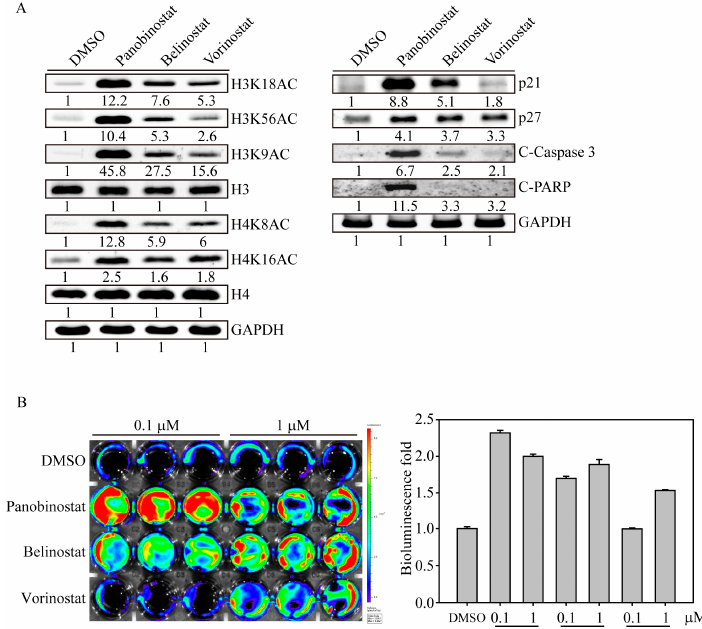
Figure 2. HDACi-induced histone acetylation and apoptosis-related protein expression. ( A ) HDACi drugs (panobinostat, belinostat and vorinostat) induced acetylation, cell cycle and apoptotic protein expression in SW579 cells. After 6 h of drug treatment, the cell lysate was collected and immunoblotted with different H3 (H3K9AC, H3K18AC and H3K56AC) and H4 (H4K8AC and H4K16AC) histone acetylation antibodies. After SW579 cells were treated for 24 h, the cell lysate was analyzed for cell cycle (p21 and p27) and apoptotic-related (C-caspase 3: cleaved caspase 3 and C-PARP: cleaved PARP) protein expression. Densitometric analysis of all western-blot was performed by ImageJ software. The protein expressions were normalized with their internal control such as H3, H4 or GAPDH expressions and shown as fold of control. ( B ) An IVIS image of HDACi-induced cell apoptosis in NIADS stably expressing SW579 (NIADS-KSW579) cells. The cells received an HDACi or DMSO in a dose-dependent manner (0.1 and 1 µM) for 24 h and the luciferase activity was analyzed (presented as the photon flux). Cells in a 24-well plate were exposed to luciferin at a concentration of 1.5 mg/mL and analyzed in an IVIS 200 Spectrum imaging system. The yellow and red colors indicate high photon counts of bioluminescence activity, whereas the green and blue colors present low photon counts of bioluminescence activity. The intense luciferase activity indicates apoptosis signals from NIADS.